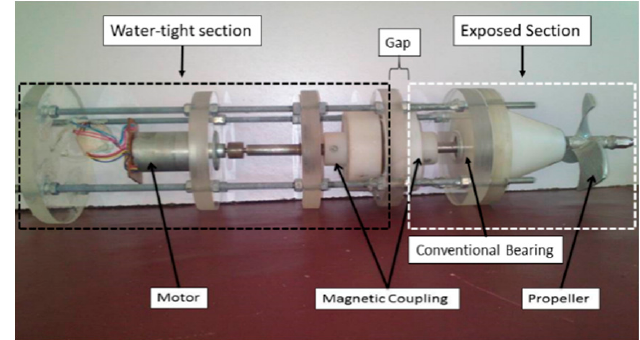
Figure 2 . Permanent magnetically coupled thruster assembly.